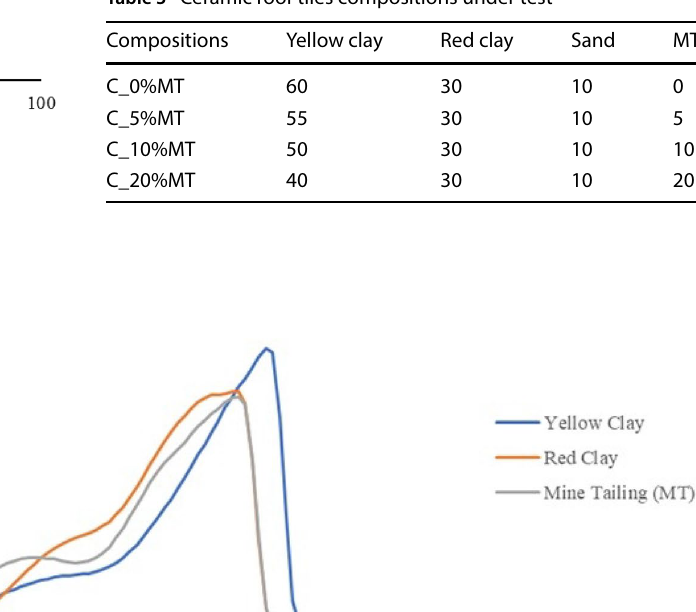
Table 3 Ceramic roof tiles compositions under